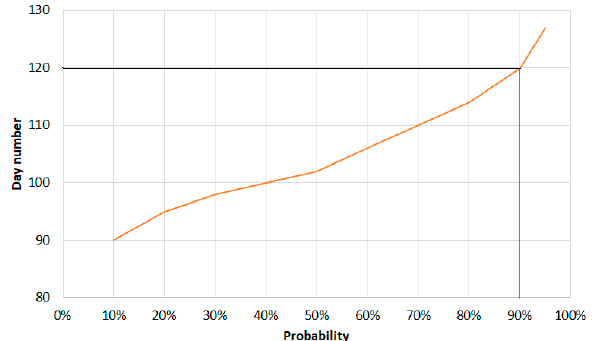
Figure 2. Probability curve for the last spring frost occurring on a specific day of the year.